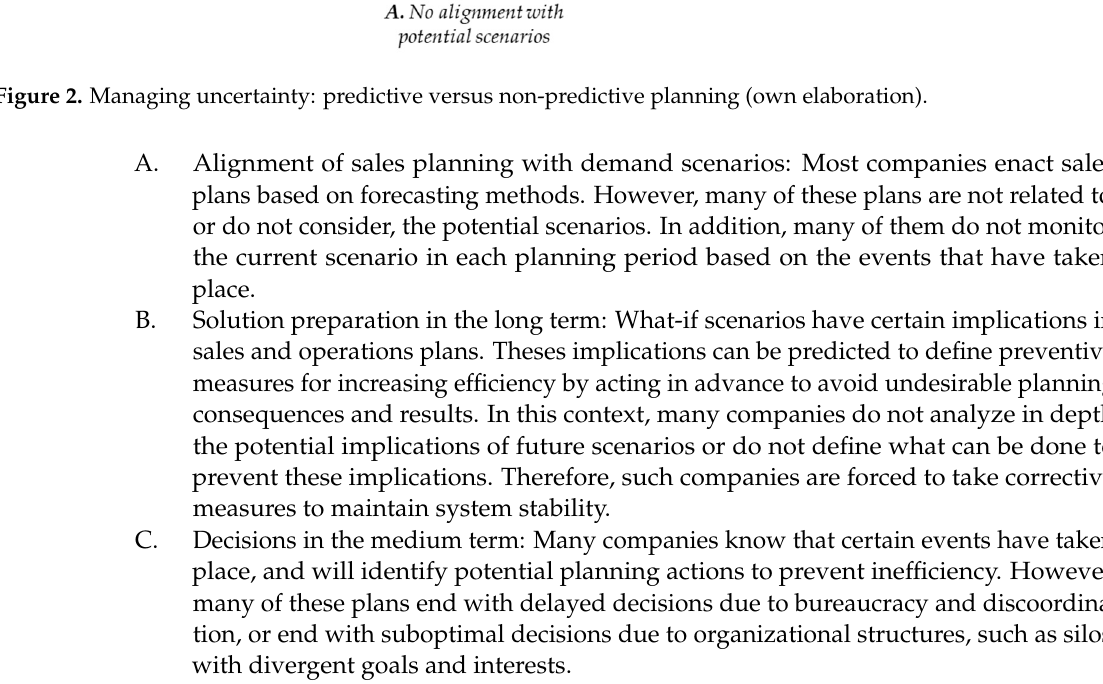
Figure 2. Managing uncertainty: predictive versus non-predictive planning (own elaboration).